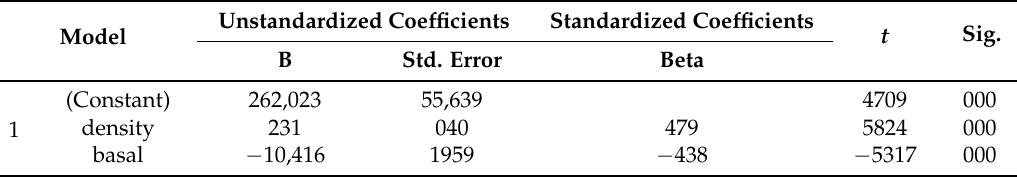
Table C2. Coefficients a